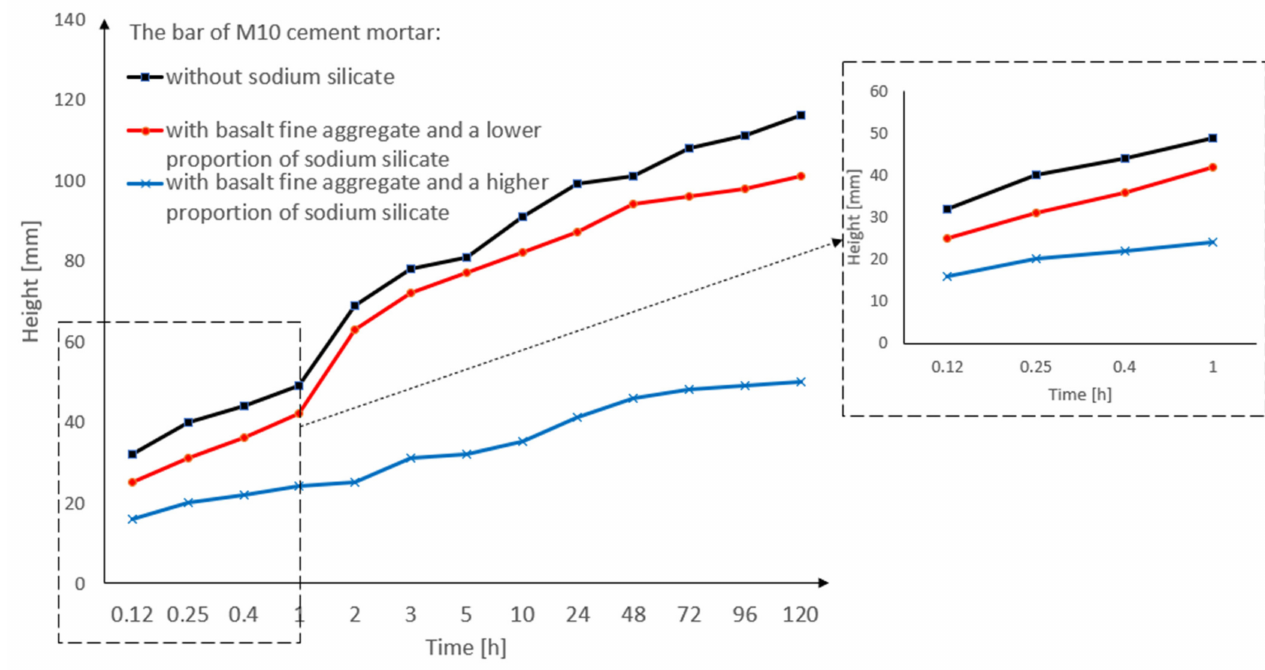
Figure 10. Capillary suction of the M10 cement mortar bar with the basalt fine aggregate: without sodium silicate, with a lower proportion of sodium silicate, with a higher proportion of sodium